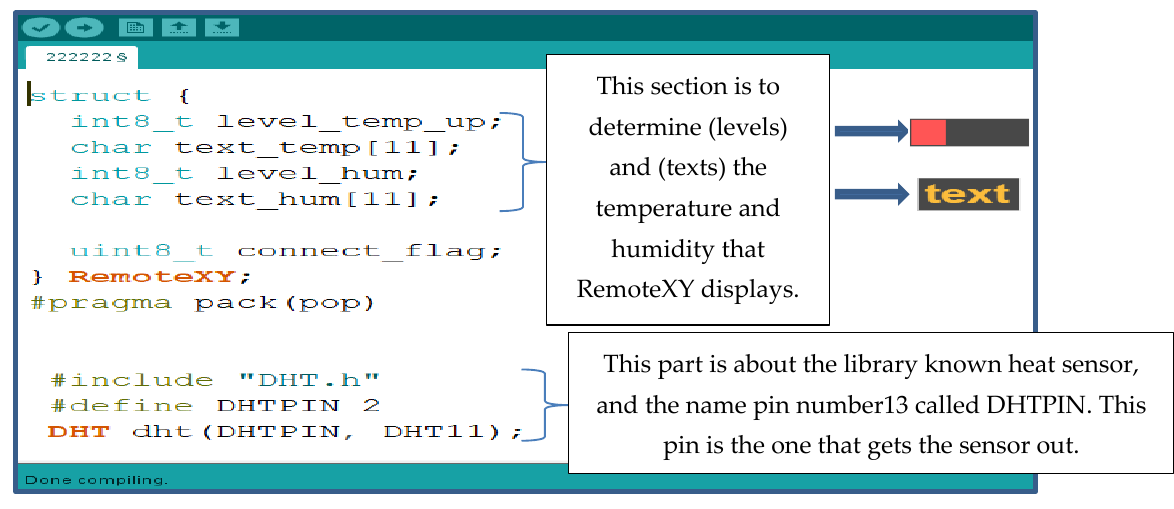
Figure A5. The first part of the executed code used to program the heat and humidity sensor.